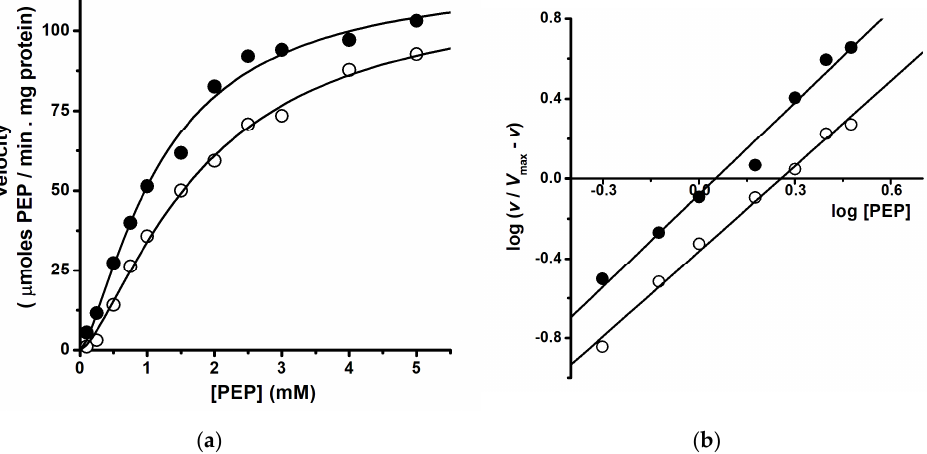
Figure 4. Activation of pyruvate kinase (PK) from G. stearothermophilus by trehalose [164]. ( a ) Cooperative kinetics of PK in the absence ( ○ ) and presence ( ● ) of trehalose. Considering the model of Monod, Wyman, and Changeux [69] in enzyme kinetics analysis: V max = 112 and 118 µ moles PEP·(min·mg protein) −1 in the absence and presence of trehalose, respectively. Affinity constants: K T = 328 and 11, and K R = 40 × 10 −4 and 5 × 10 −4 mM phospho enol pyruvate (PEP) in the absence and presence of trehalose, respectively. The Hill number ( n ) was ≈1.5, both in the absence and presence of trehalose. The ratio [ T 0 ]/[ R 0 ] ( L ) increases ~13 times in the presence of trehalose. ( b ) Hill plot of PK cooperative kinetics of data in a (symbols as in a). The slope ( n ) value in both straight lines is ≈1.5. Adapted with permission from Rivera-Moran [164]. Copyright © 2020, M.A. Rivera Moran.